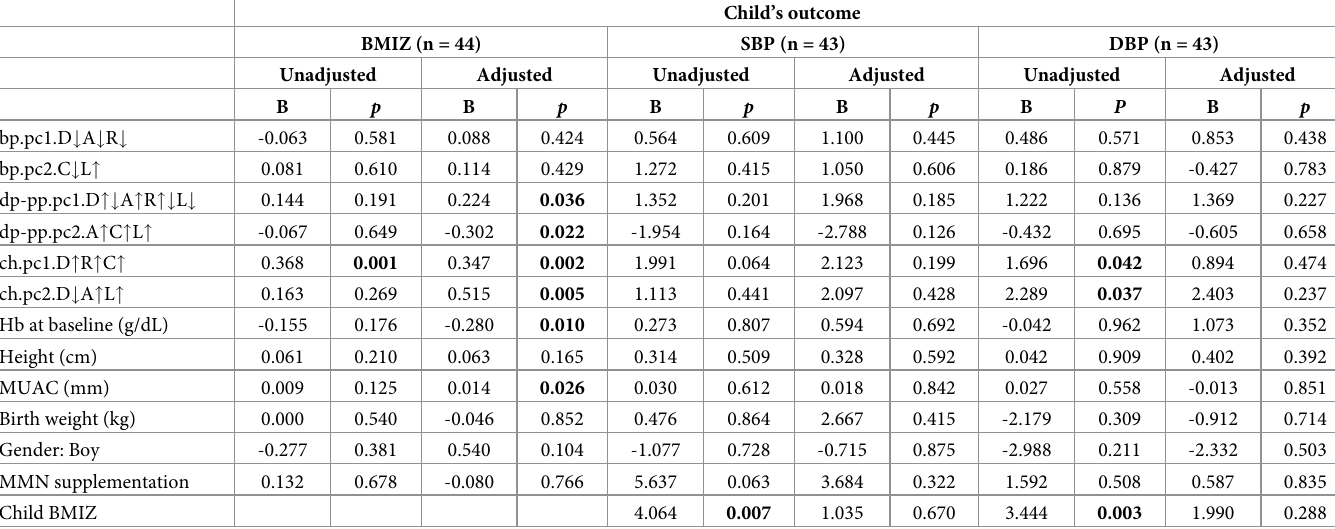
Table 7. Associations of maternal and child components and nutritional characteristics with child body mass index and blood